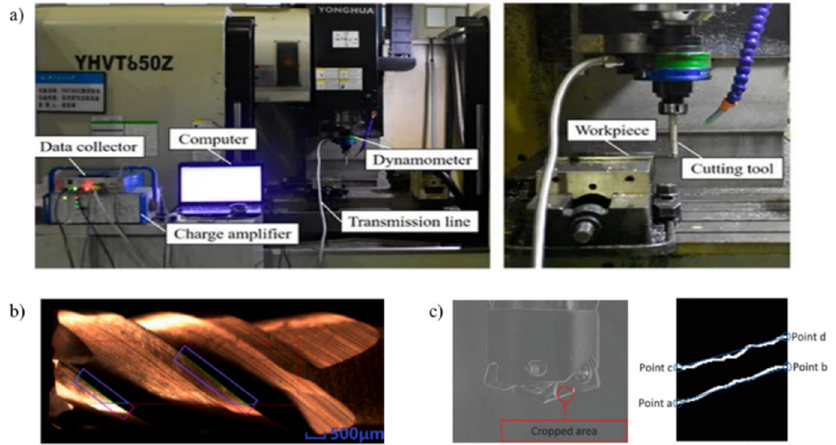
Figure 1. ( a ) Cutting tool on-line monitoring physical platform [4]; ( b ) Tiny-yolo network detection results [37] ; ( c ) Contour recognition effect of a milling cutter [2] .